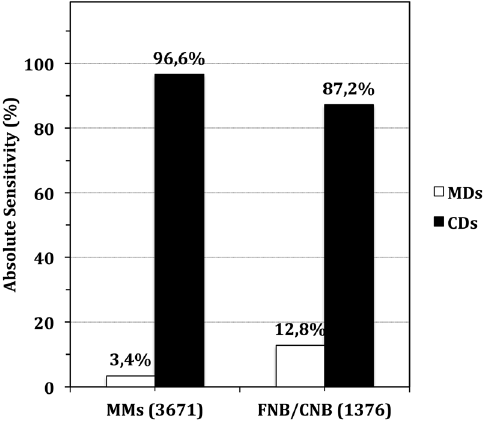
Figure 1: The percent AS vs. percent correctly diagnosed (%CD) and percent mis-diagnosed (%MD) BC patients plot, using MM and FNB (CNB)